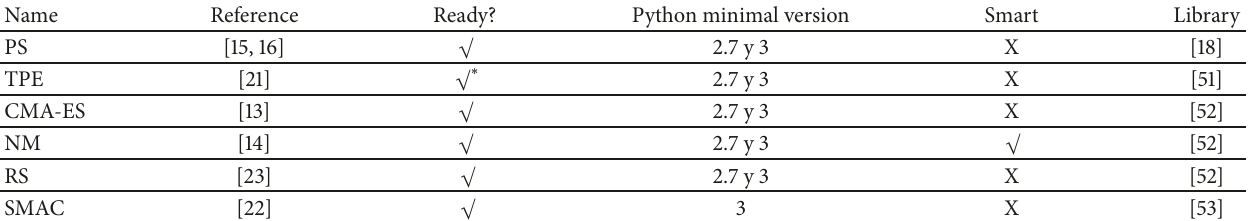
Table 1: HPO algorithms. The star symbol ∗ means that the chosen algorithms have needed some minor